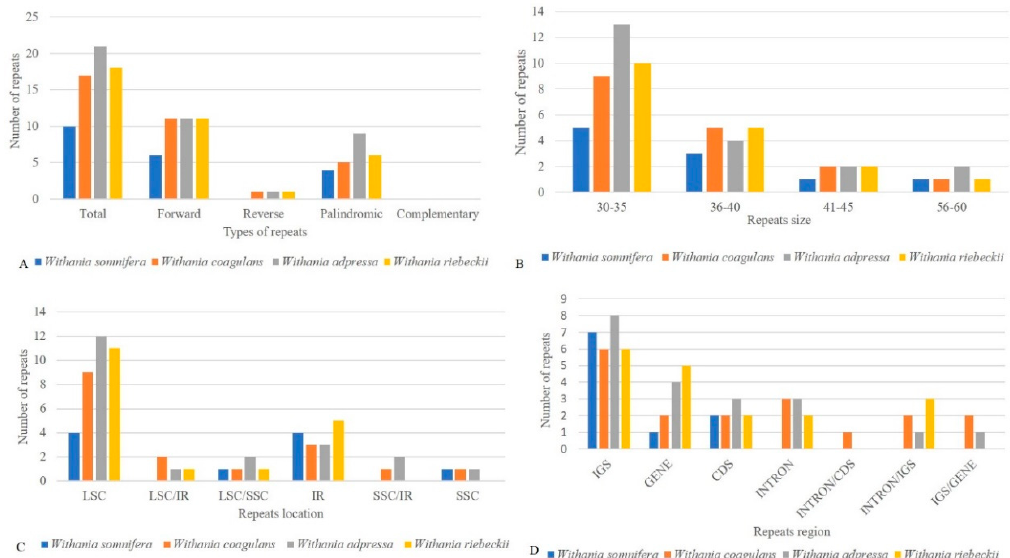
Figure 6. ( A ) The total number of oligonucleotide repeats among Withania species and their distribution according to specific characteristics. ( B ) The distribution of repeats in size ranges. ( C ) The number of repeats grouped according to their location in each structural region ( D ) The distribution of repeats in intergenic spacer regions (IGS), genes, coding DNA sequences (CDS), and introns and their proportionate occurrence.